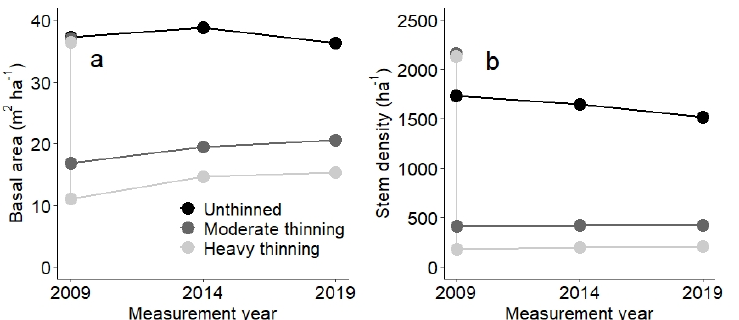
Figure 2. Basal area ( a ) and stem density ( b ) of three oak-hornbeam stands with contrasting management. For the first measurement in year 2009, we show before and after treatment conditions for the thinned stands.